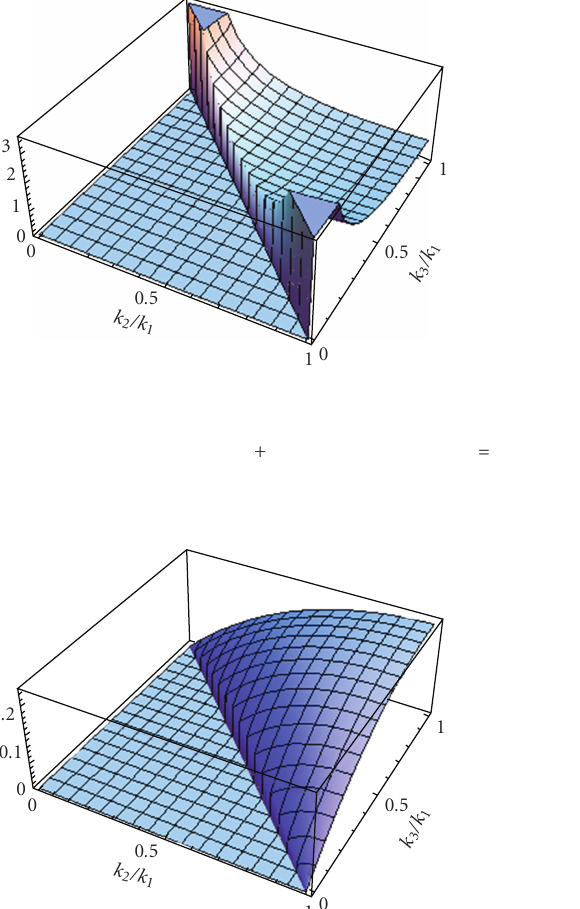
Figure 17: A mixing of the equilateral (Figure 4) and local shape (Figure 16).